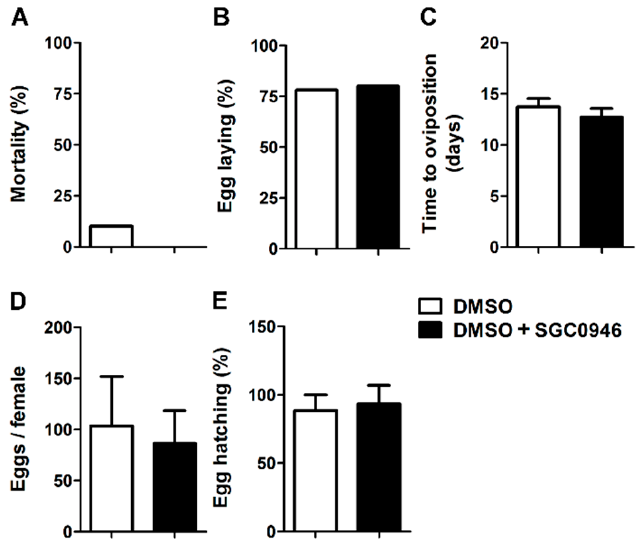
Figure 5. Effect of inhibitor SGC0946 in adult female O. moubata . Ticks were placed in an artificial feeding system and allowed to fed until repletion with bovine blood. The blood, with and without the inhibitor SGC0946 dissolved in DMSO was supplemented with gentamycin and ATP as feeding stimulant. The final concentration of the inhibitor in the blood was 0.02 µ M. After engorgement, the ticks were kept in controlled conditions of humidity and temperature and adult female mortality ( A ) egg laying ( B ), time to oviposition ( C ), eggs per female ( D ), and egg hatching ( E ) were monitored. Chi-squared ( χ 2 ) test was used for comparison in (A), (B), and (E) and unpaired t test was used for comparison in (C) and (D). No significant difference between the inhibitor and the control groups was observed for any of the parameters, p > 0.05.